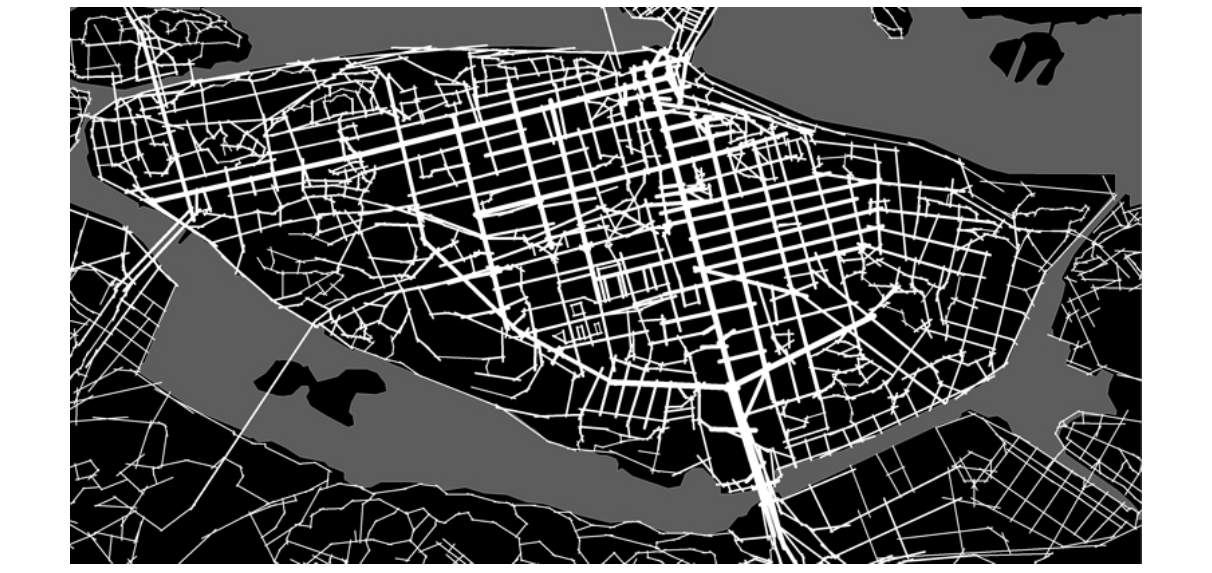
Fig. 4 . Integration (or closeness centrality), calculated in an axial map (fat lines represent high integration and thin lines represents